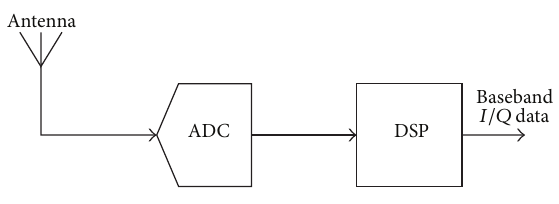
Figure 1: Ideal Software Defined Radio